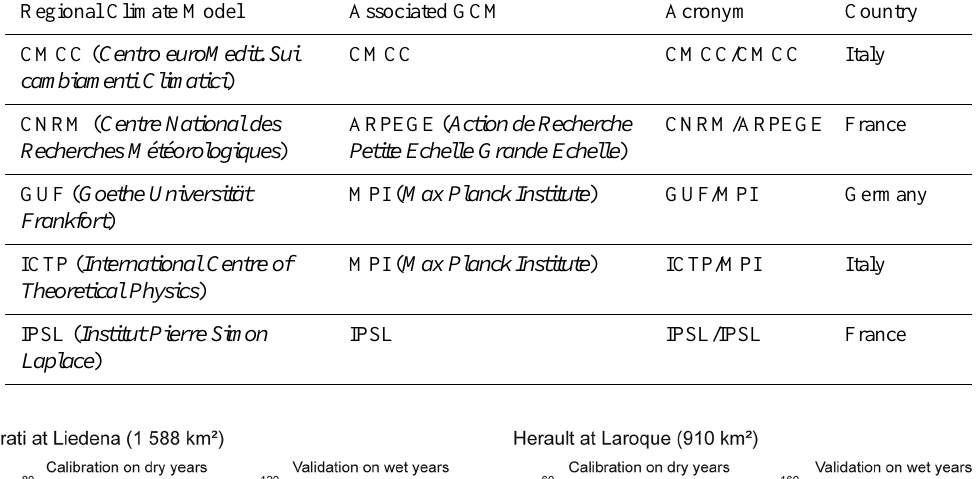
Table 1. Name and origin of the five 50 × 50km Regional Climate Models (RCM) used in the study.